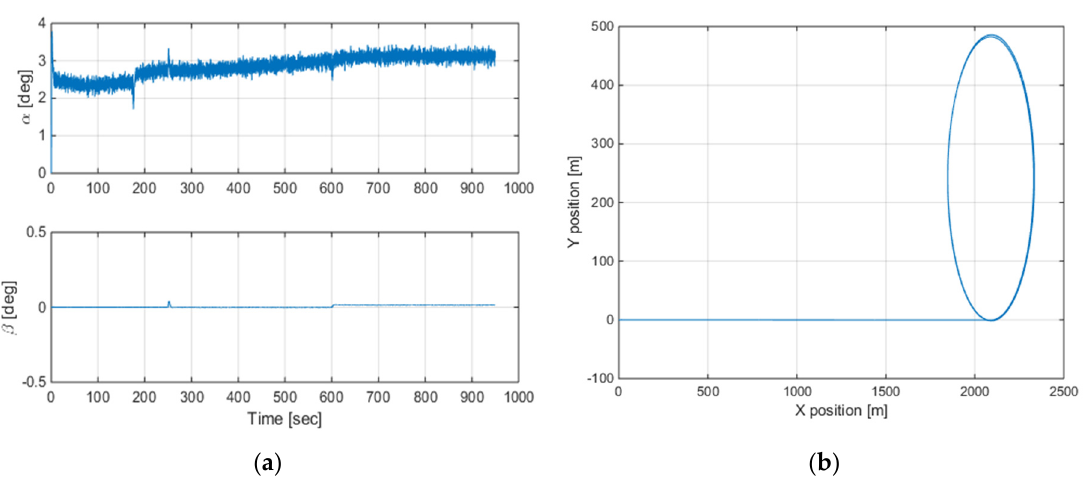
Figure 17. Simulation results: ( a ) Alpha and Beta, ( b ) Circular Motion. The height profile of the solar UAV with axial location is also shown in Figure 18a.